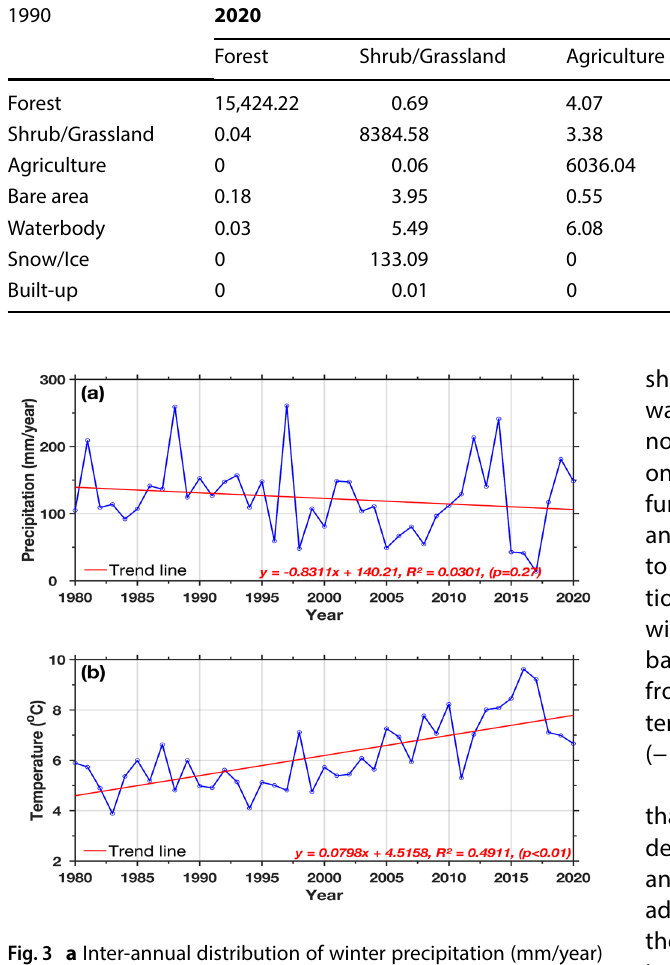
Fig. 3 a Inter-annual distribution of winter precipitation (mm/year) and b temperature (°C) over KRB during 1980–2020. The red line represents the linear